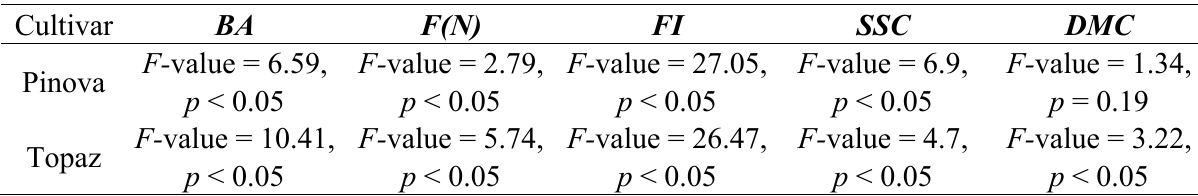
Table 3. F- value and p -values of two-way ANOVA for combined series*day effect for individual cultivars. BA means biospeckle activity, F–firmness, FI–firmness index, SSC–soluble solids content, DMC–dry matter content.